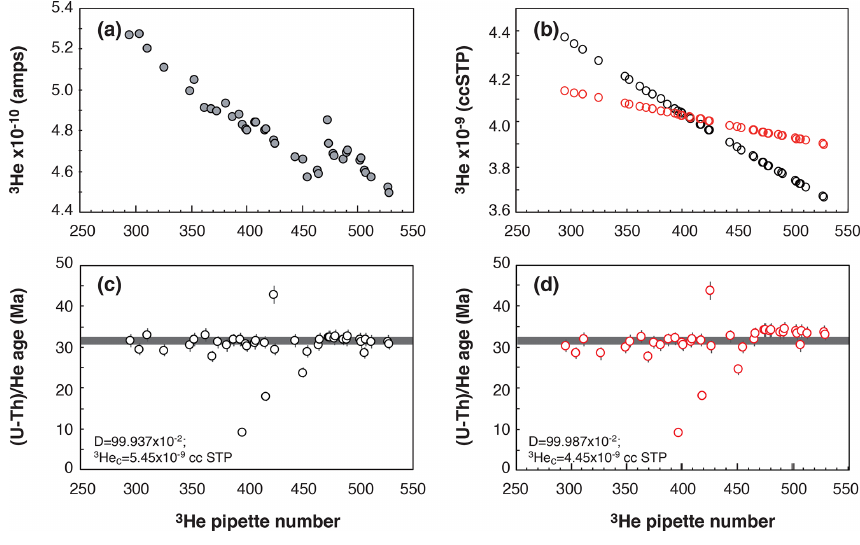
Figure 4. Evolution of the Durango apatite age as a function of pipette number. (a) Evolution of the 3 He signal over the period of analysis. (b) Evolution of the calculated 3 He content of each pipette for two different D drift values (black dots or red dots) and 3 He c calibrated content using Eq. (2). (c, d) Calculated Durango AHe ages for the different D drift values and 3 He c calibrated